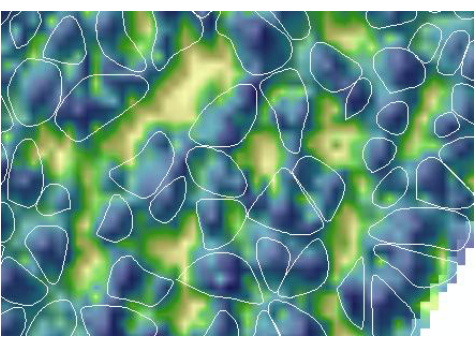
Figure 22. A portion of the area with over segmented